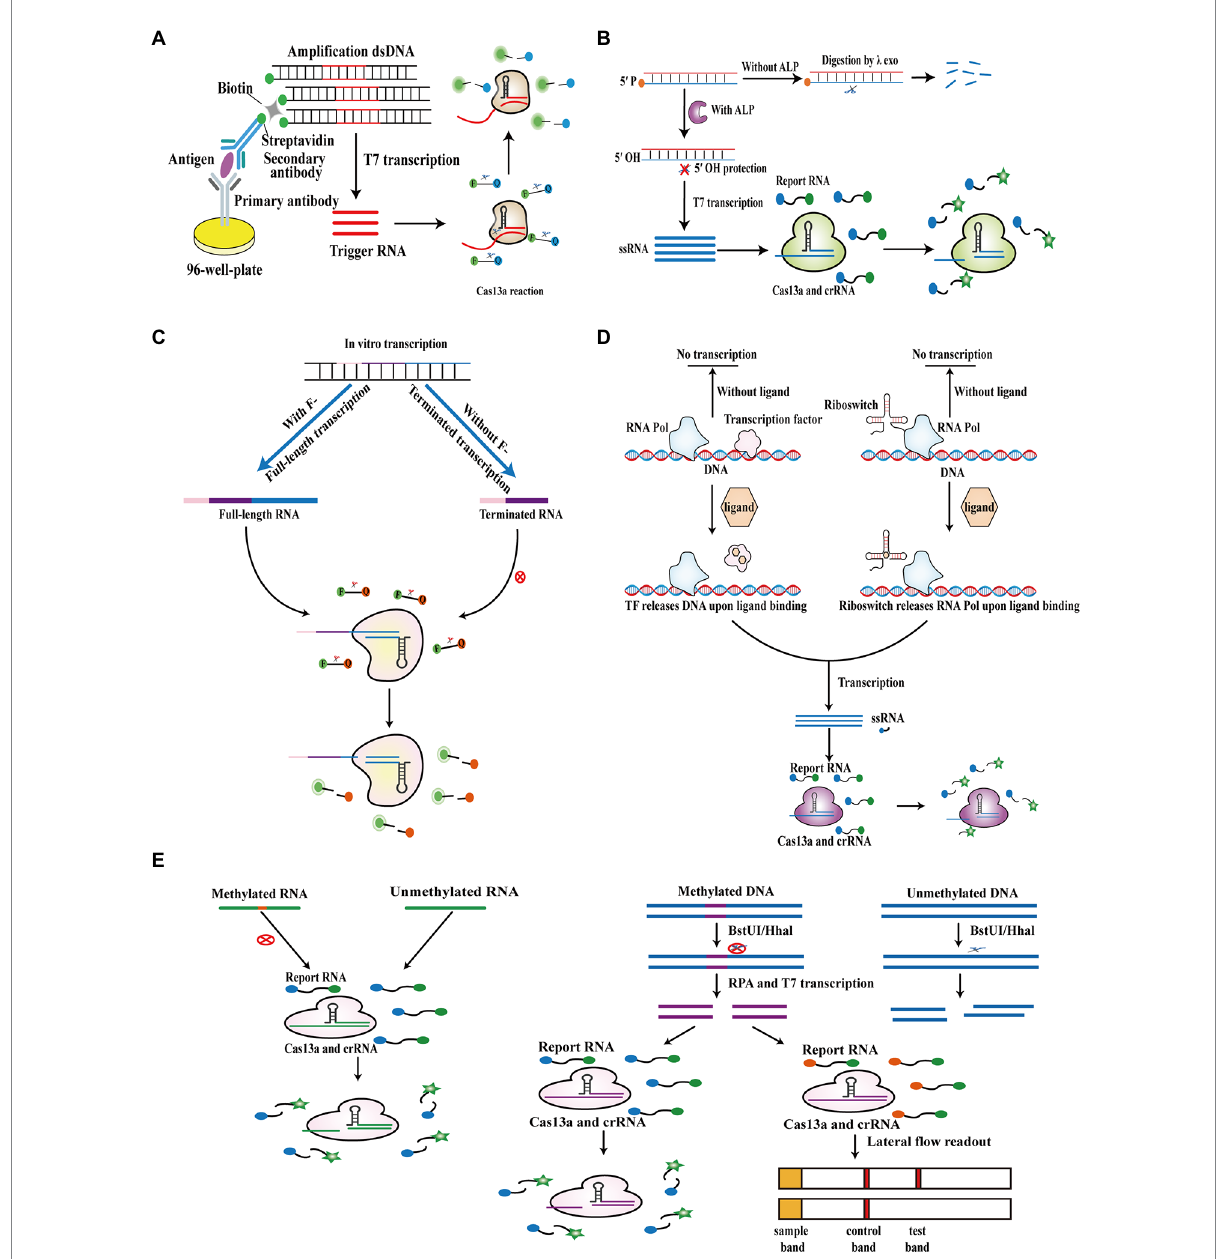
FIGURE 5 Cas13a-based biosensors for non-nucleic acid target detection. (A) Schematic of CLISA. Horseradish peroxidase in ELISA is replaced by biotinylated dsDNA containing a T7 promoter sequence to achieve Cas13a-based detection of antigen. (B) Schematic of TITAC-Cas. In the presence of ALP, 5 ′ P-dsDNA is converted into 5 ′ OH-dsDNA, avoiding digestion by λ exo and activating the downstream T7 transcription and the Cas13a reaction. (C) Schematic of Cas13a-based biosensor for fluoride detection. In the absence of fluoride, template DNA is transcribed into terminated RNA, which cannot be recognized by the Cas13a system. Instead, in the presence of fluoride, template DNA is transcribed into full- length RNA, which can activate the downstream Cas13a reaction. (D) Schematic of SPRINT. The presence of ligands leads to the release of DNA by transcription factor or the release of RNA pol by riboswitch. Subsequently, the transcription products are recognized by the Cas13a system and activate the trans-cleavage activity of Cas13a. (E) Schematic of Cas13a-based biosensor for RNA and DNA methylation detection. Methylated RNA is not recognized by the Cas13a system due to the mismatch between methylated and unmethylated bases (above at left). Methylated DNA cannot be digested by BstUI/HhaI and then initiates the downstream RPA, T7 transcription, and the collateral cleavage activity of Cas13a (above at